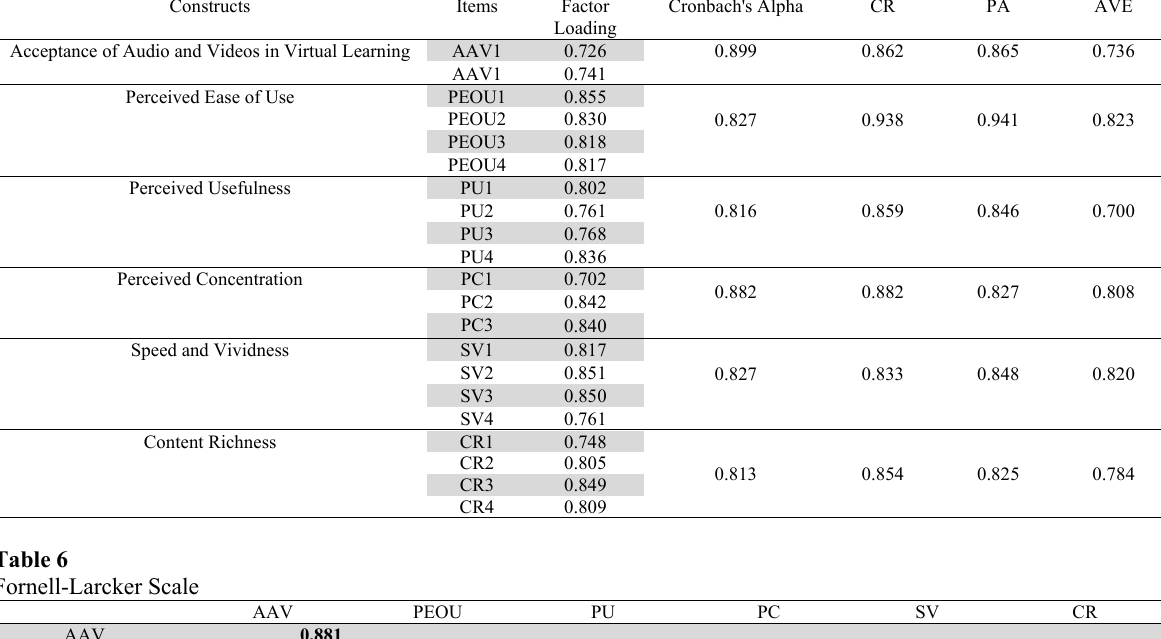
Convergent validity results which assure acceptable values (Factor loading, Cronbach’s Alpha, composite reliability ≥ 0.70 & AVE > 0.5)